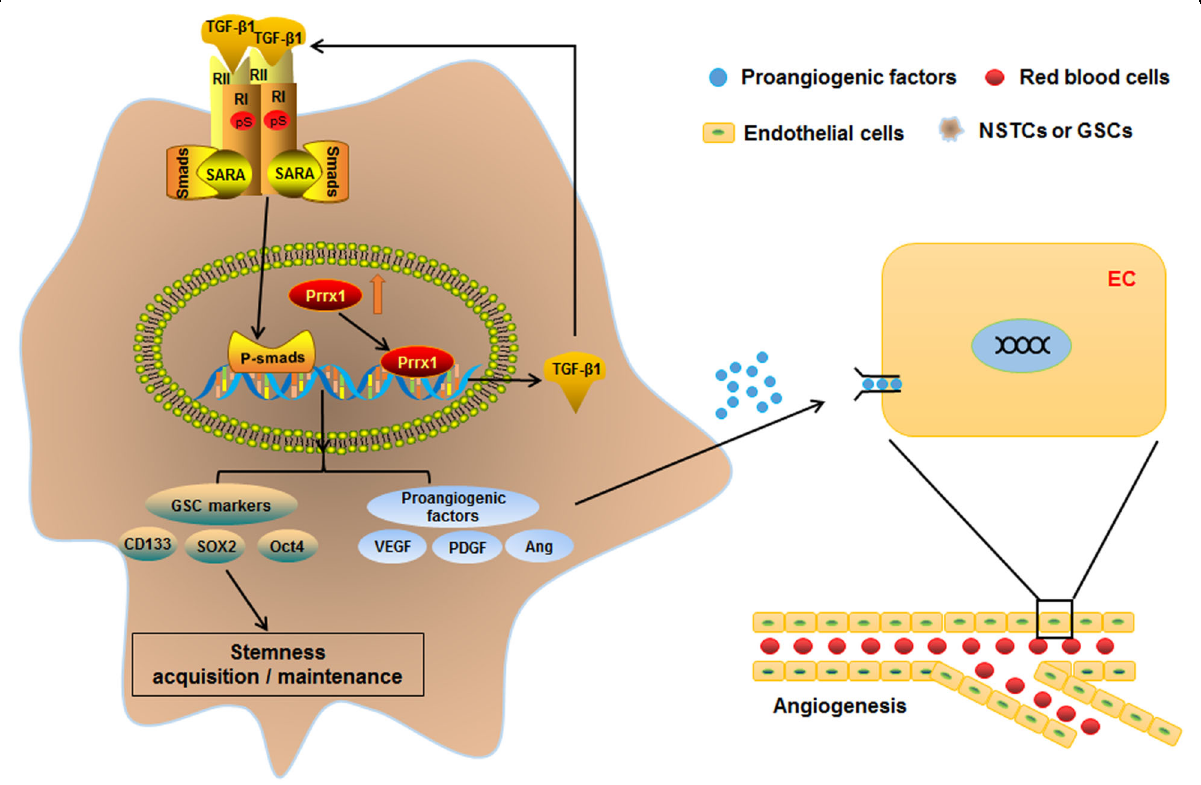
Fig. 8 Schematic diagram of the mechanism of Prrx1 mediated malignant phenotypes in glioma. Prrx1 plays a critical role in regulating glioma stemness and angiogenesis. On the one hand, Prrx1 upregulated TGF- β 1 expression by directly binding to the promoter region as a transcription factor. The autocrine TGF- β 1 activates the TGF- β /smad pathway, upregulates the stemness and proangiogenic related genes, and consequently promotes stemness and angiogenesis in glioma. On the other hand, the paracrine TGF- β 1 as well as other proangiogenic factors like VEGF act on the endothelial cells, promote their migration and tube formation ability and consequently stimulate the formation of glioma